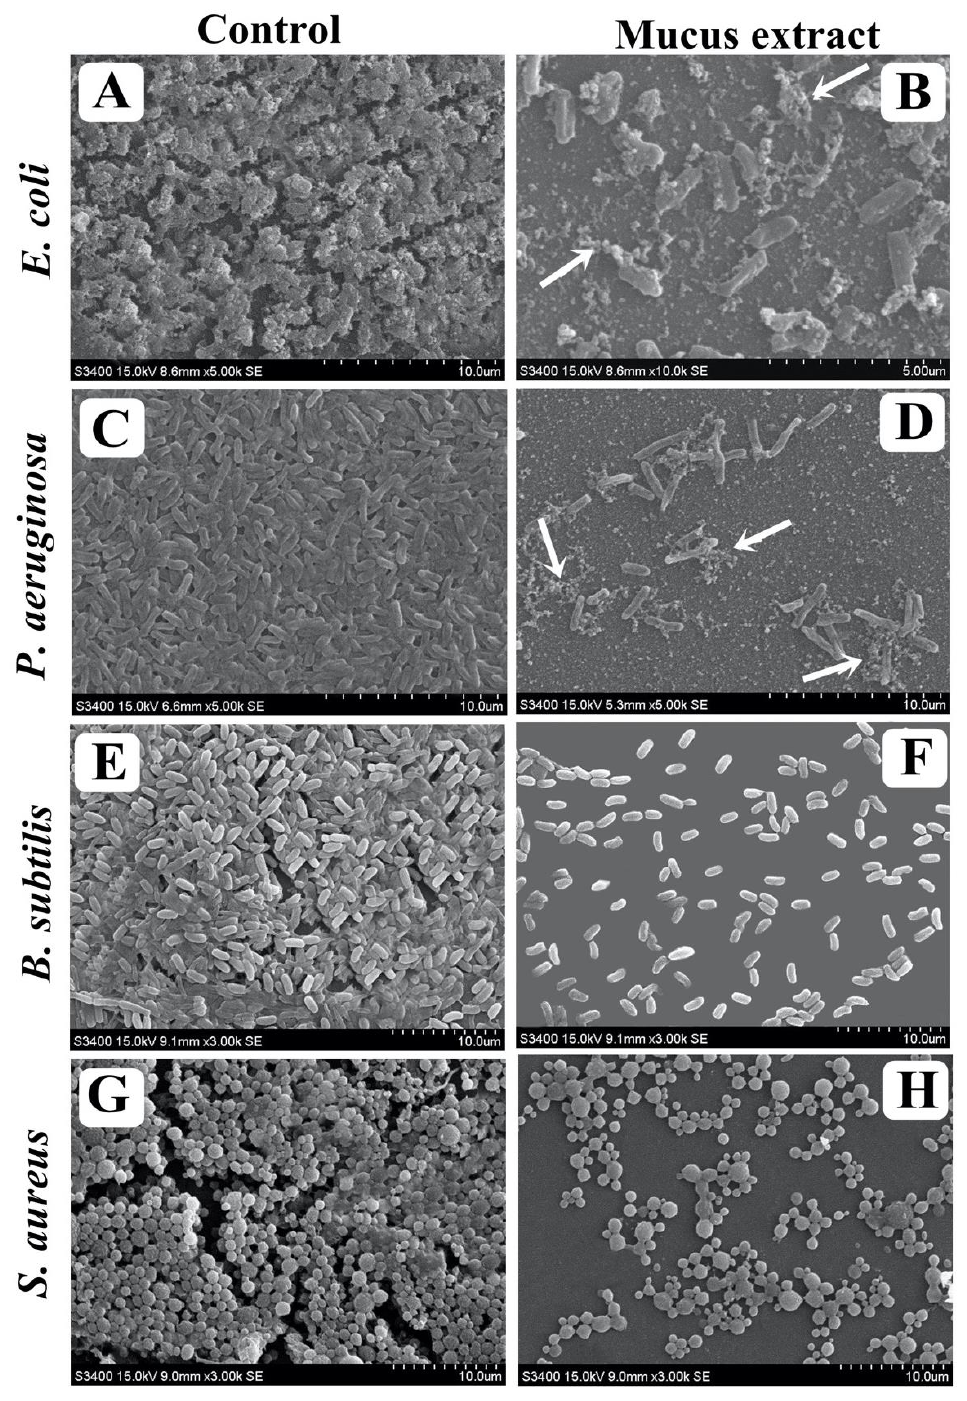
Figure 8. Micrographs of disrupted matured biofilms of tested strains formed on glass surfaces by P. sophore mucus extract at their respective MICs under scanning electron microscopy. ( A , C , E , G ) Growth control, ( B , D , F , H ) P. sophore mucus extract. Arrows indicated lysis of bacterial cells in ( B ) and ( D ).